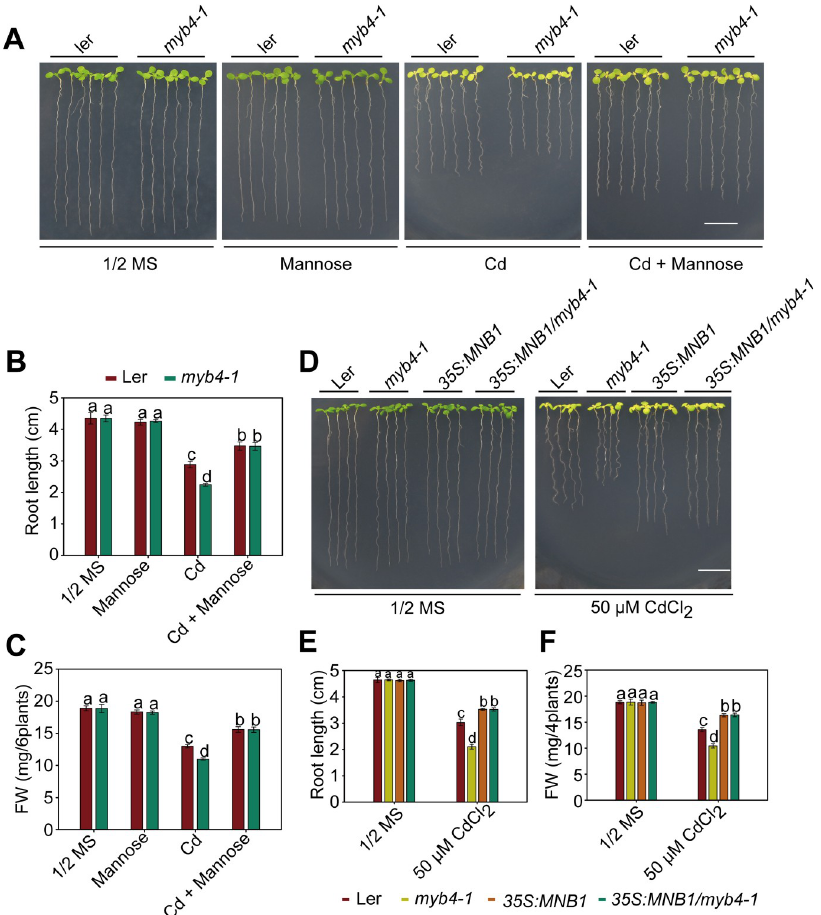
fresh weight of plants described in (A). (D) Cd stress phenotypes of the Ler, myb4-1 , MNB1-OE , and MNB1-OE/myb4- 1 seedlings. (E, F) Root length and fresh weight of plants described in (D). In (A) and (D), three-day-old seedlings grown on 1/2 MS medium were transferred to 1/2 MS media with or without 50 μ M CdCl 2 or 1.5 mM mannose for about 2 weeks. Scale bar = 1 cm. In (B), (C), (E), and (F), three independent experiments were done with similar results, each with three biological replicates. Four plants per genotype from one plate were measured for each replicate. Data are presented as means ± SD, n = 3. Bars with different lowercase letters are significantly different at P < 0.05 (Tukey’s